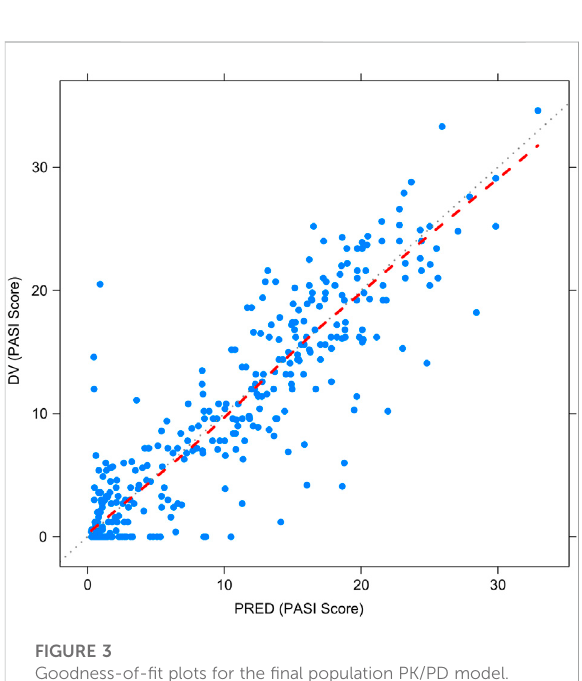
FIGURE 4 Goodness-of- fi t plots for the fi nal population PK/PD model. The conditional weighted residuals (CWRES) vs. population- predicted PASI score (PRED).